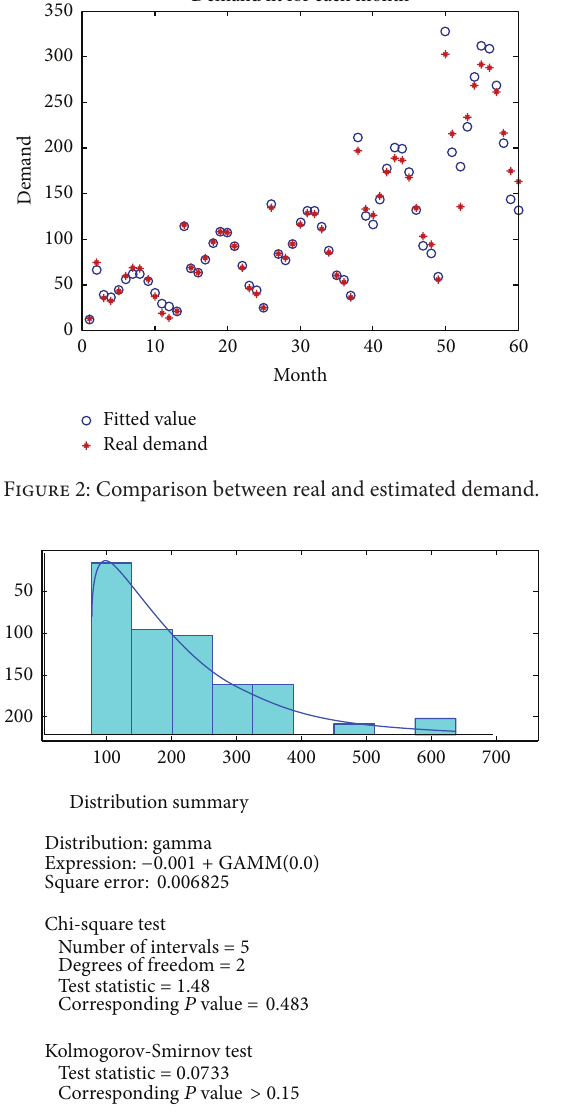
Table 8: Decision matrix for product 𝐵